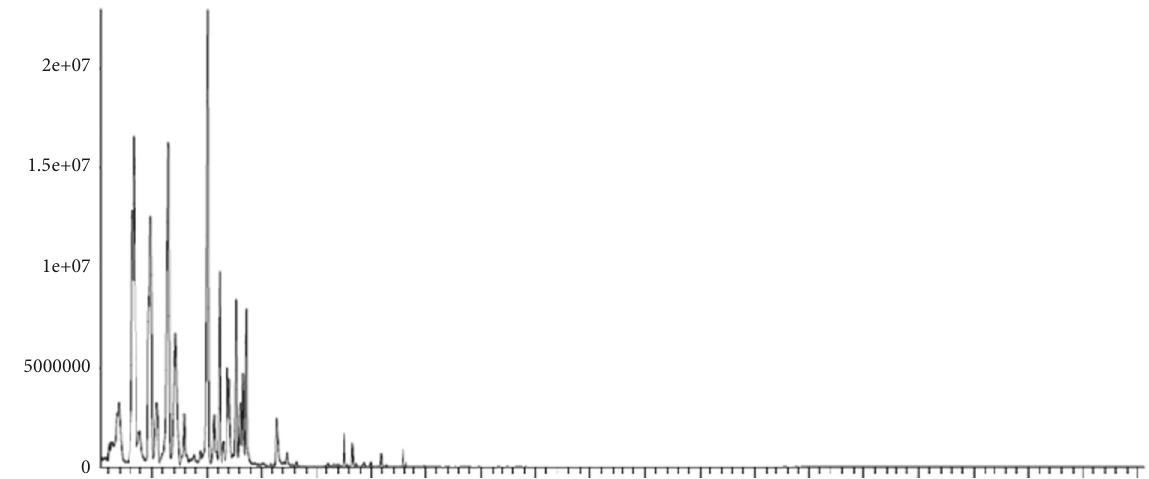
Figure 3: Chromatogram of essential oils of rosemary extracted by